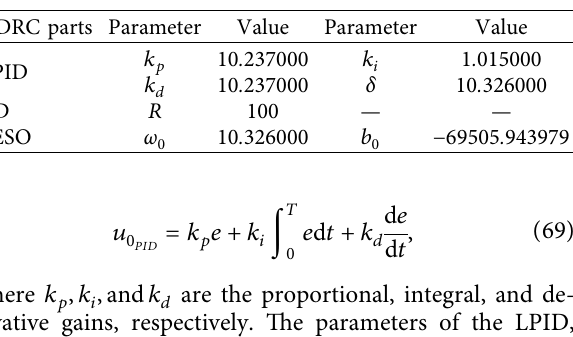
Figure 5: The output response when the disturbance is applied at t � 50s. (a) The average queuing length q ( t ) . (b) The window size W ( t ) . (c) The round trip time R ( t ) (d). The probability of losing packets u ( t ) . The performance index values are shown in Table 6. As dem- onstrated, the proposed controllers (NLPID and STC-SM) show noticeable improvements in OPI of 63 . 7363% and 72 . 52524%, respectively. The proposed controllers thus demonstrate effectiveness based on smooth response and minimized OPI. Table 6: Performance indices. Table 7: LADRC